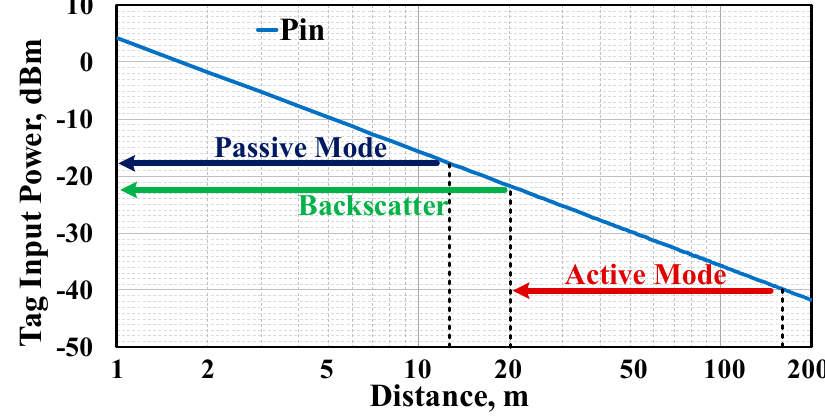
Figure 1. Read range and operating modes of ultra-high-frequency (UHF) radio frequency identification (RFID) system.